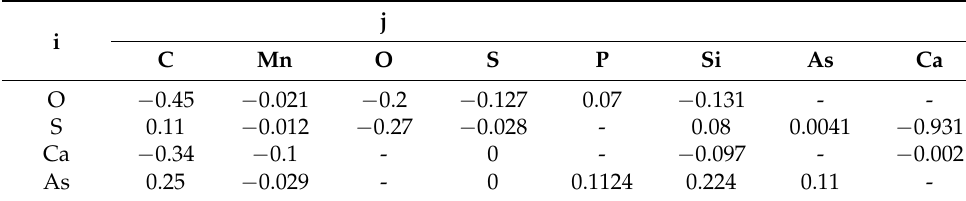
Table 4. Solute interaction coefficient at 1873